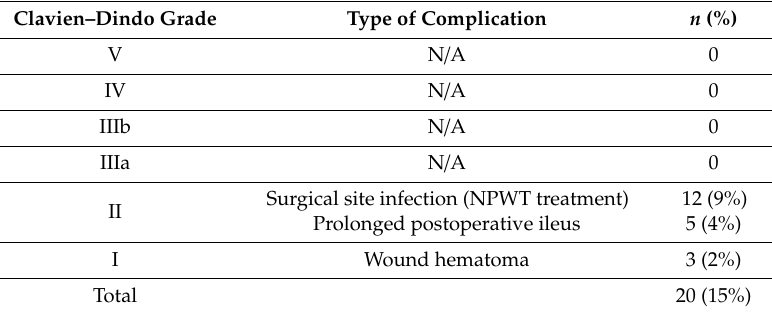
Table 3. Postoperative morbidity after ileostomy